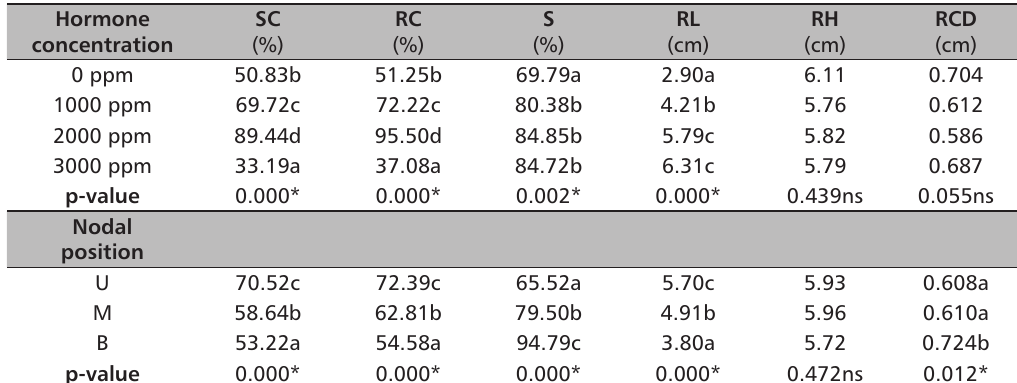
Means with similar alphabet within the same column of any set of treatments are not significantly different at p = 0.05 SC - sprouted cuttings; RC - rooted cuttings; S - survival; RL - root length; RH - ramet height; RCD - ramet collar diameter; U - upper; M - middle; B - base * - significant (p < 0.05); ns - not significant (p > 0.05)